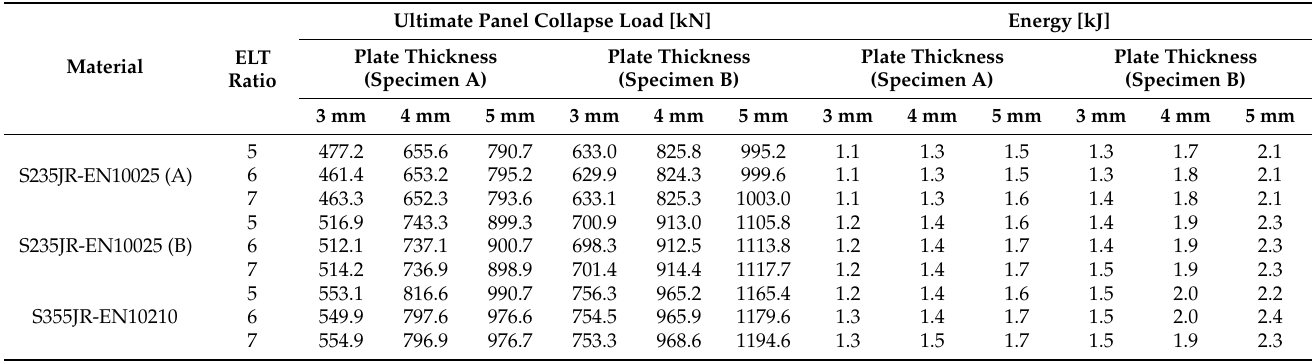
Table 10. Effect of the materials and plate thickness to ultimate panel collapse loads.